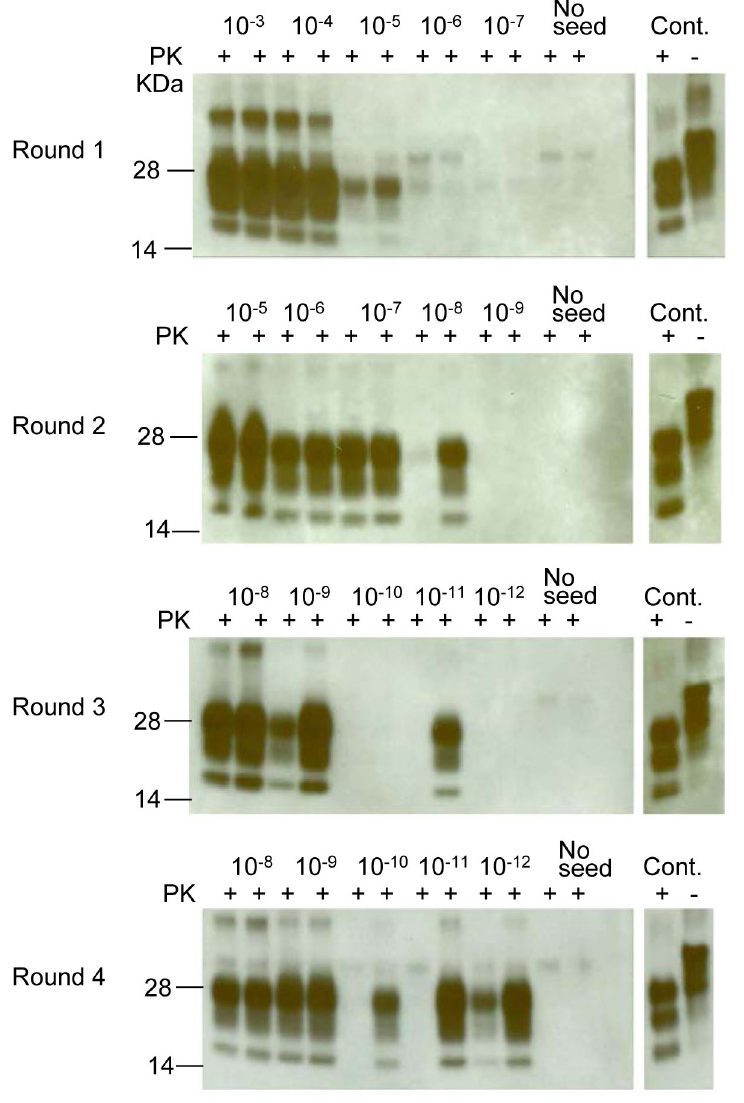
Figure 7. PMCA with dilution series of vCJD human brain homogenate. Human vCJD brain material was diluted 10 -3 -10 -12 into 10% RBVS/S saline-perfused NBH and subjected to 4 rounds of PMCA. Human vCJD 5% brain homogenate was loaded as a positive control (Cont.) in all 4 rounds. Round 1 shows the products of 10 -3 -10 -7 dilutions, Round 2 shows the products of 10 -5 -10 -9 dilutions, Round 3 shows the products of 10 -8 -10 -12 dilutions, Round 4 shows the products of 10 -8 -10 -12 dilutions. Prior to electrophoresis, samples were digested with PK. All blots were stained with 6D11 antibody except the controls lanes that were stained with 3F4 antibody. doi: 10.1371/journal.pone.0078710.g007 those obtained by others using PMCA [14]. Assuming that these PrP TSE concentrations estimated for the scrapie hamster model are similar to PrP TSE concentrations in brain and in blood of humans infected with vCJD, then, a 10 -12 dilution of 10% human brain homogenate should correspond to 6 x 10 -18 g of PrP TSE per mL. This initial concentration of PrP TSE –a concentration more than 5,000-fold lower than the concentration of PrP TSE estimated to be present in infected plasma (excess ratio = 3.2 x 10 -14 g mL -1 /6 x 10 -18 g mL -1 ) was